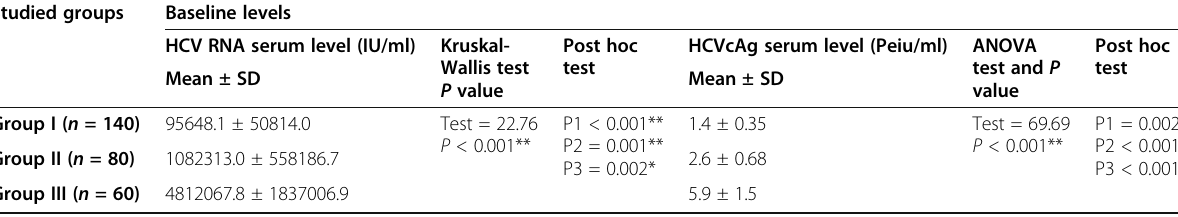
Table 2 Mean values of baseline levels for both HCV RNA (IU/ml) and HCVcAg (Peiu/ml) assays among the studied groups Studied